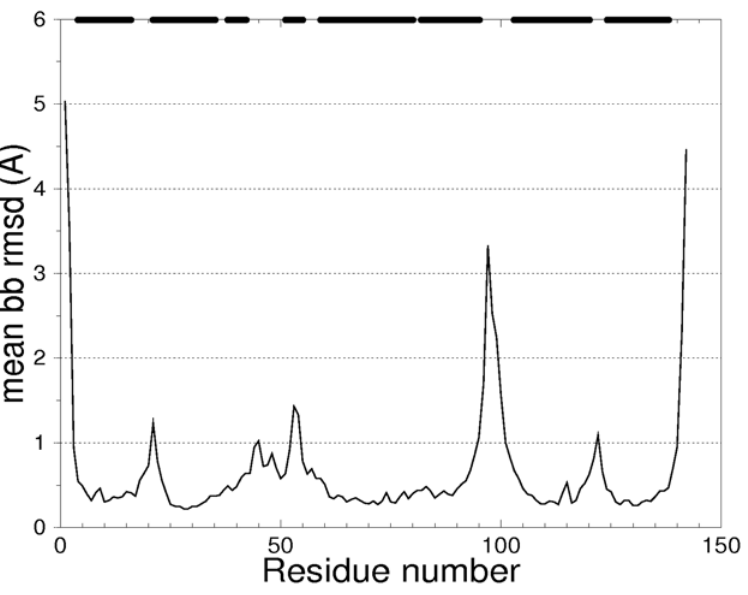
Figure 4. Mean backbone (bb) RMSD per residue for 100 models of 1flp h1 testcase for D seq=0. Secondary structure elements limits are indicated by horizontal bars on the upper x axis. Regions of high variability correspond to loops.